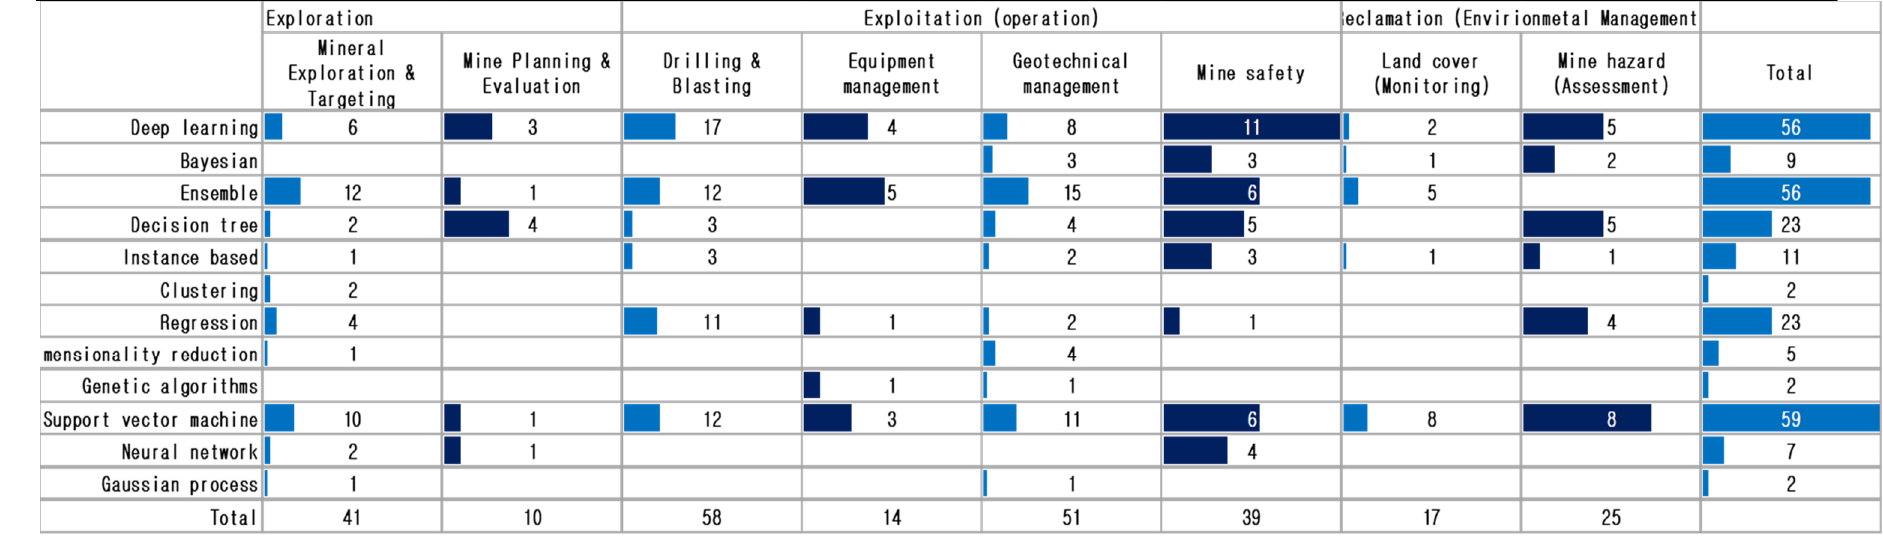
Figure 10. Mining applications underpinned by ML models.